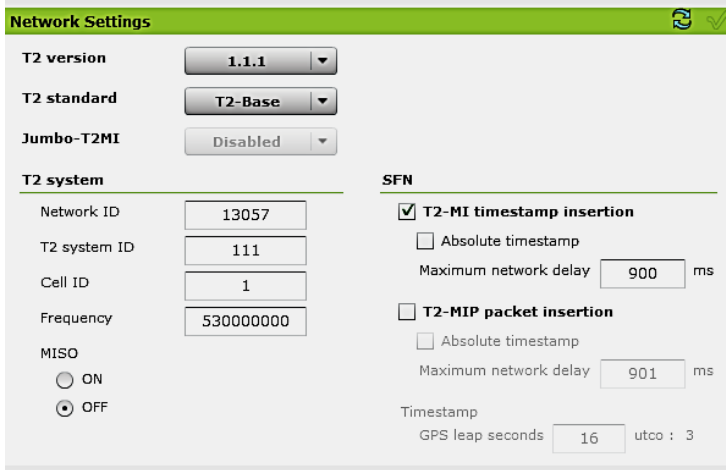
Figure 7. Menu "T2 Gateway": Option - Network Settings.